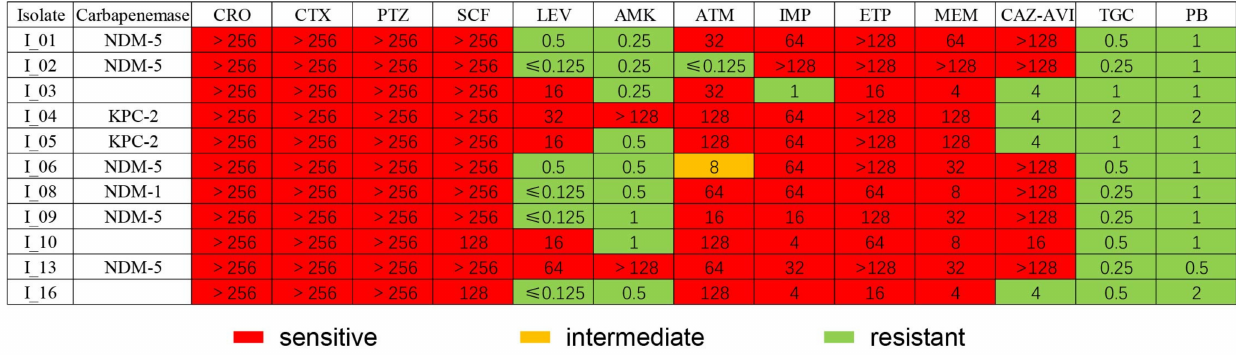
Figure 3. Carbapenemmase and antimicrobial MICs analysis of eleven strains of CRE in